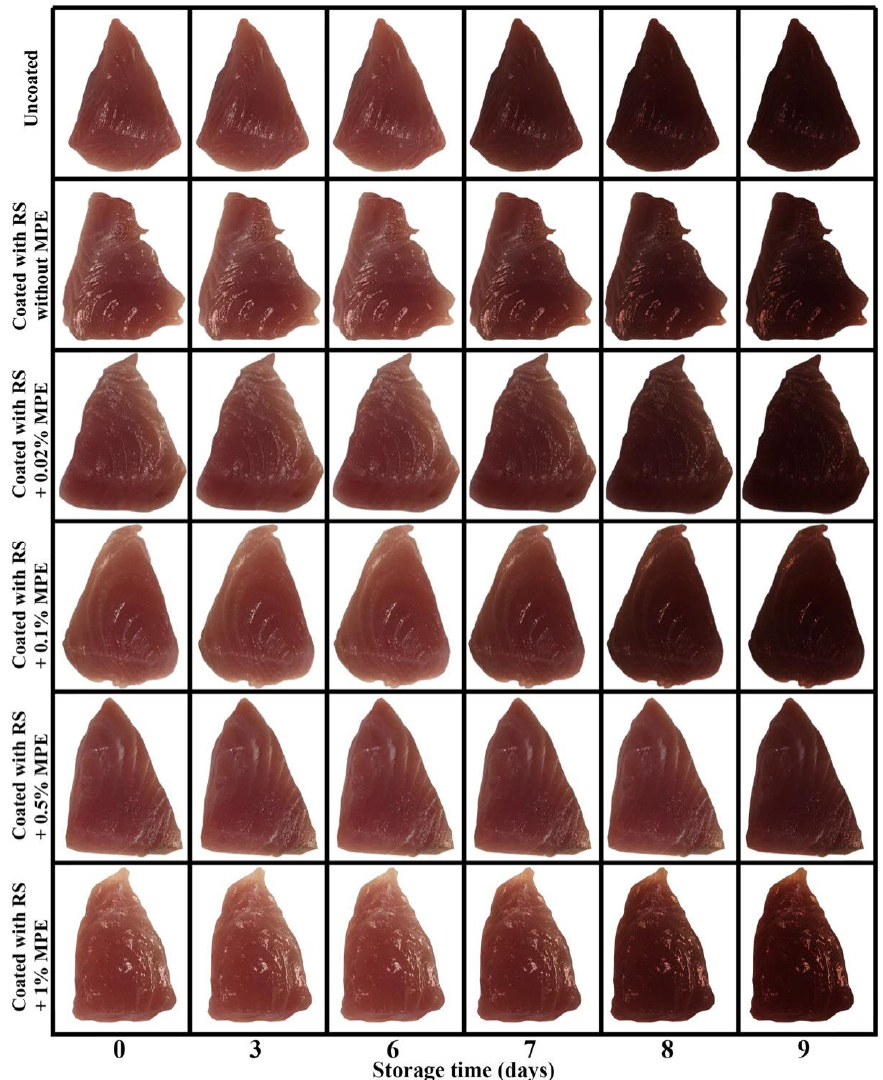
Figure 3. Changes in the appearance and color of mackerel slices over the course of storage at 4 °C as influenced by coating with rice starch (RS) containing Mon-pu extract (MPE) at different concen- trations.